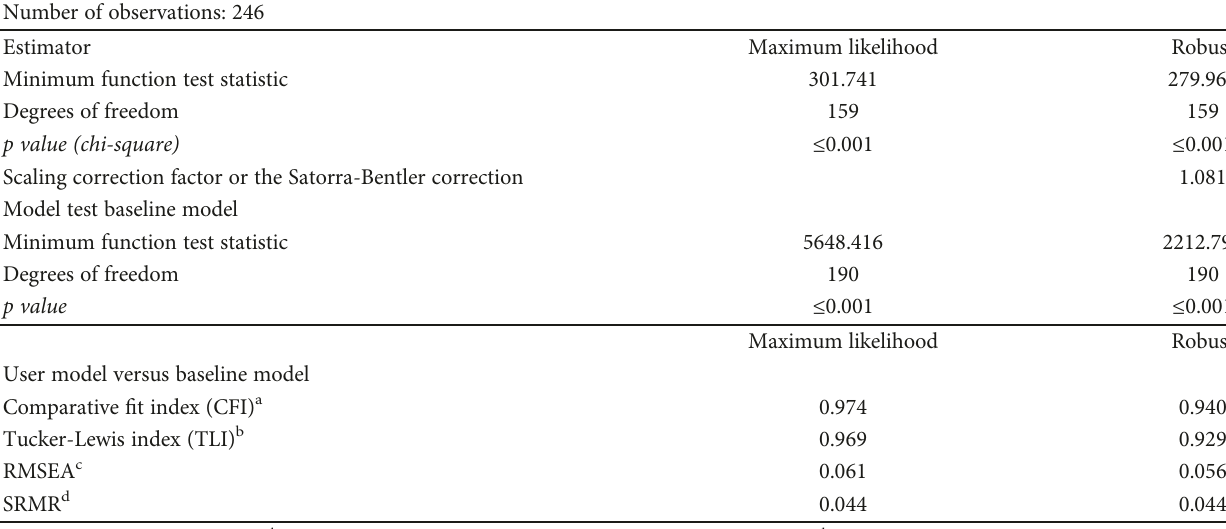
Table 4: Measures of the model fi